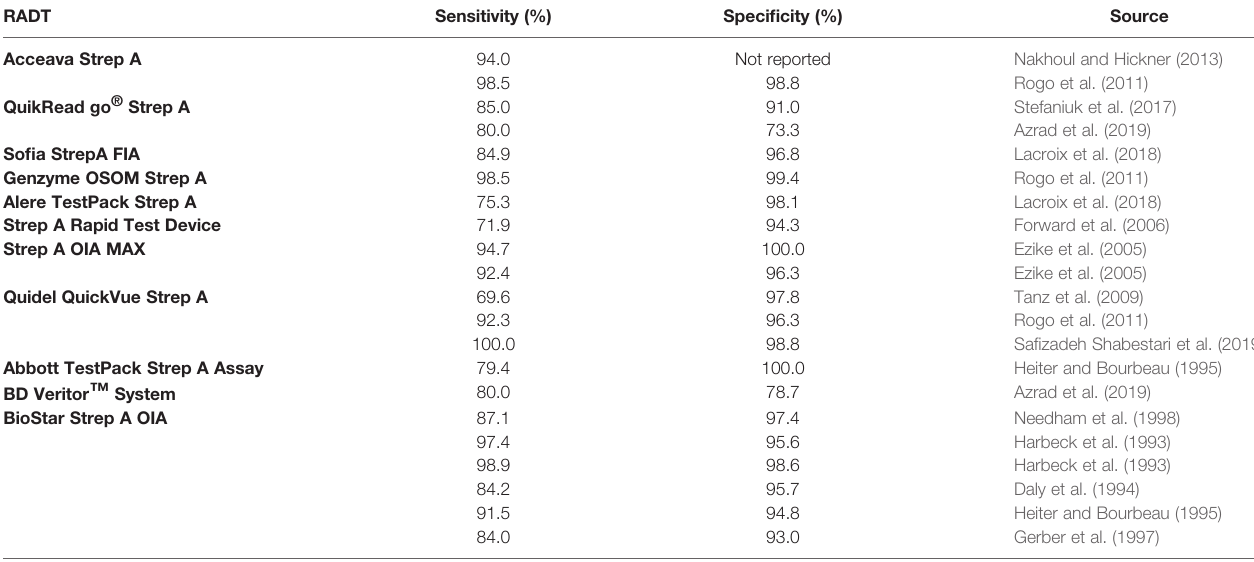
TABLE 2 | Sensitivity and Speci fi city of Select Rapid Antigen Detection